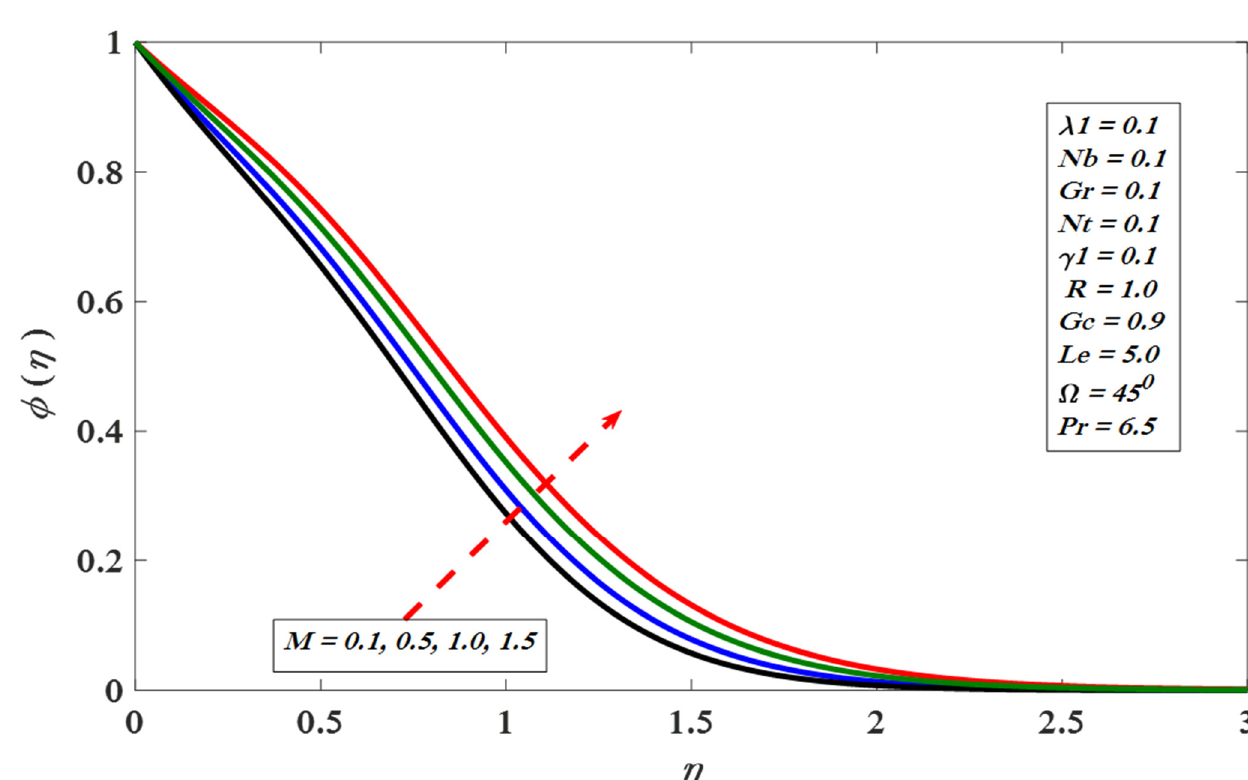
Figure 12. Concentration profile versus M .